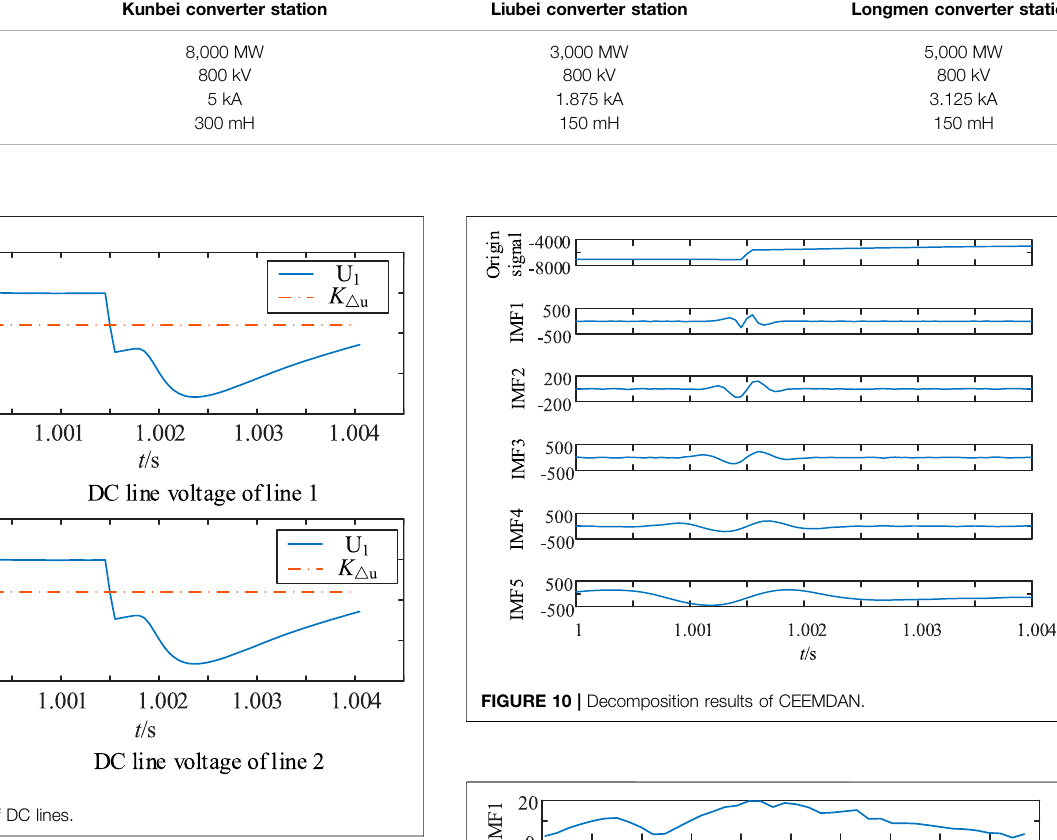
FIGURE 8 | Voltage of DC lines.